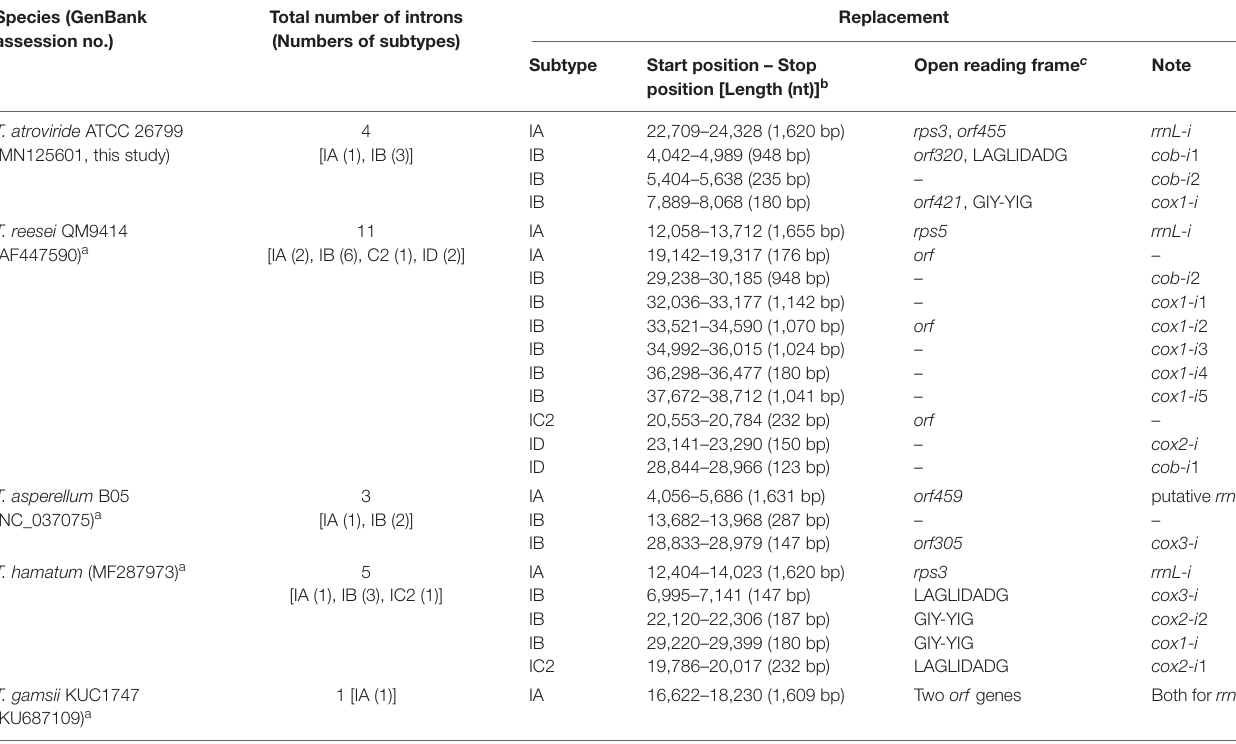
TABLE 3 | Detected group I intron loci on the mitochondrial genomes of Trichoderma species. Species (GenBank assession